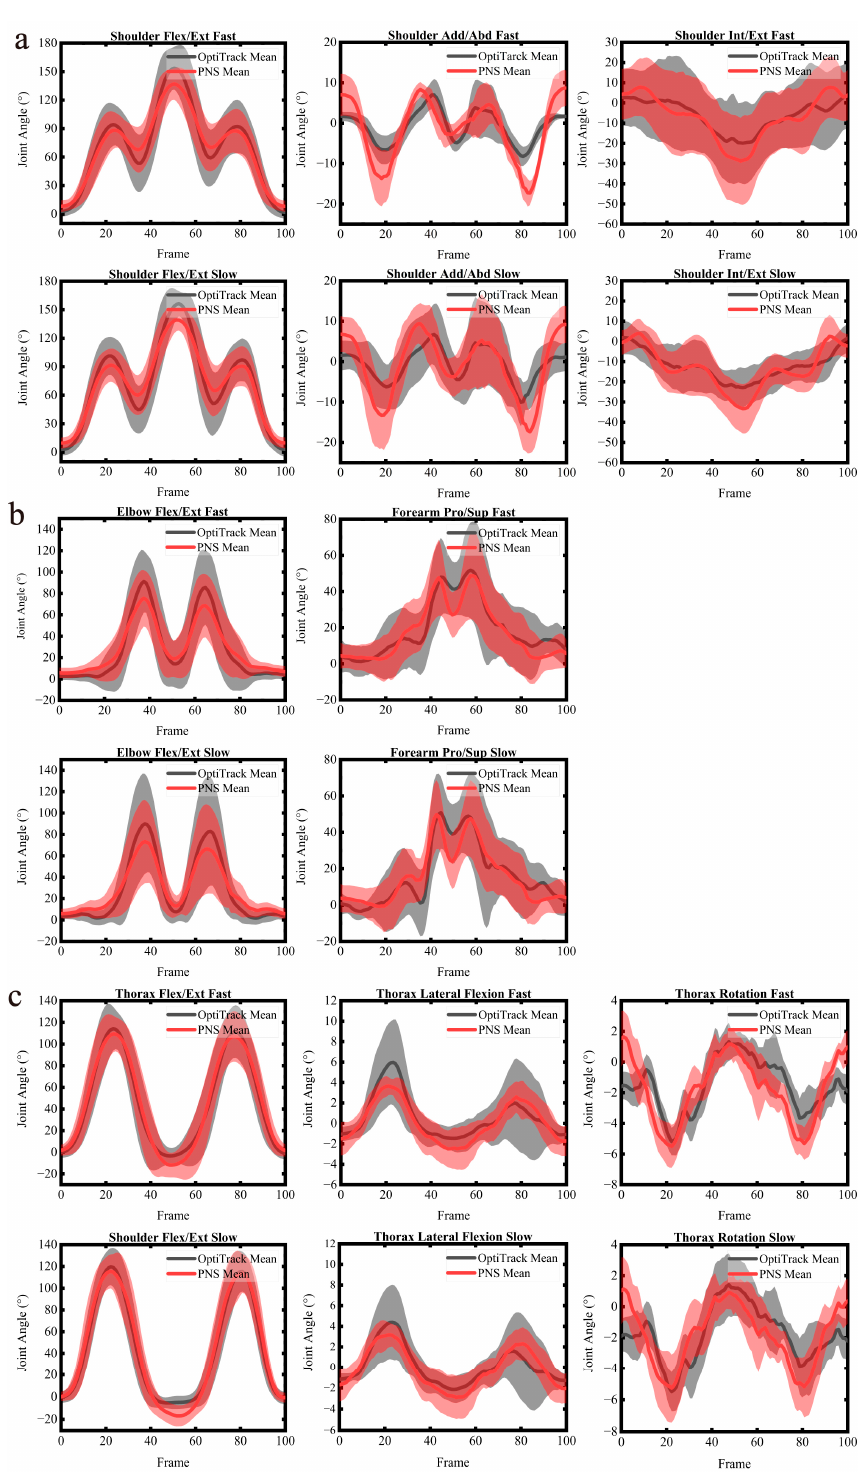
Figure 2. Comparison of the PNS and OptiTrack’s mean angular curves during the complex task. ( a – c ) The mean angular curves of the shoulder ( a ), elbow ( b ), and trunk ( c ). The thick solid line represents the mean angular curve for the PNS (red) and OptitTrack (black), and the shadow area represents standard deviations from the mean angular curve. Note that Add/Abd, Flex/Ext, Int/Ext, and Pro/Sup stand for adduction/abduction, flexion/extension, internal/external rotation, and pro- nation/supination, respectively.